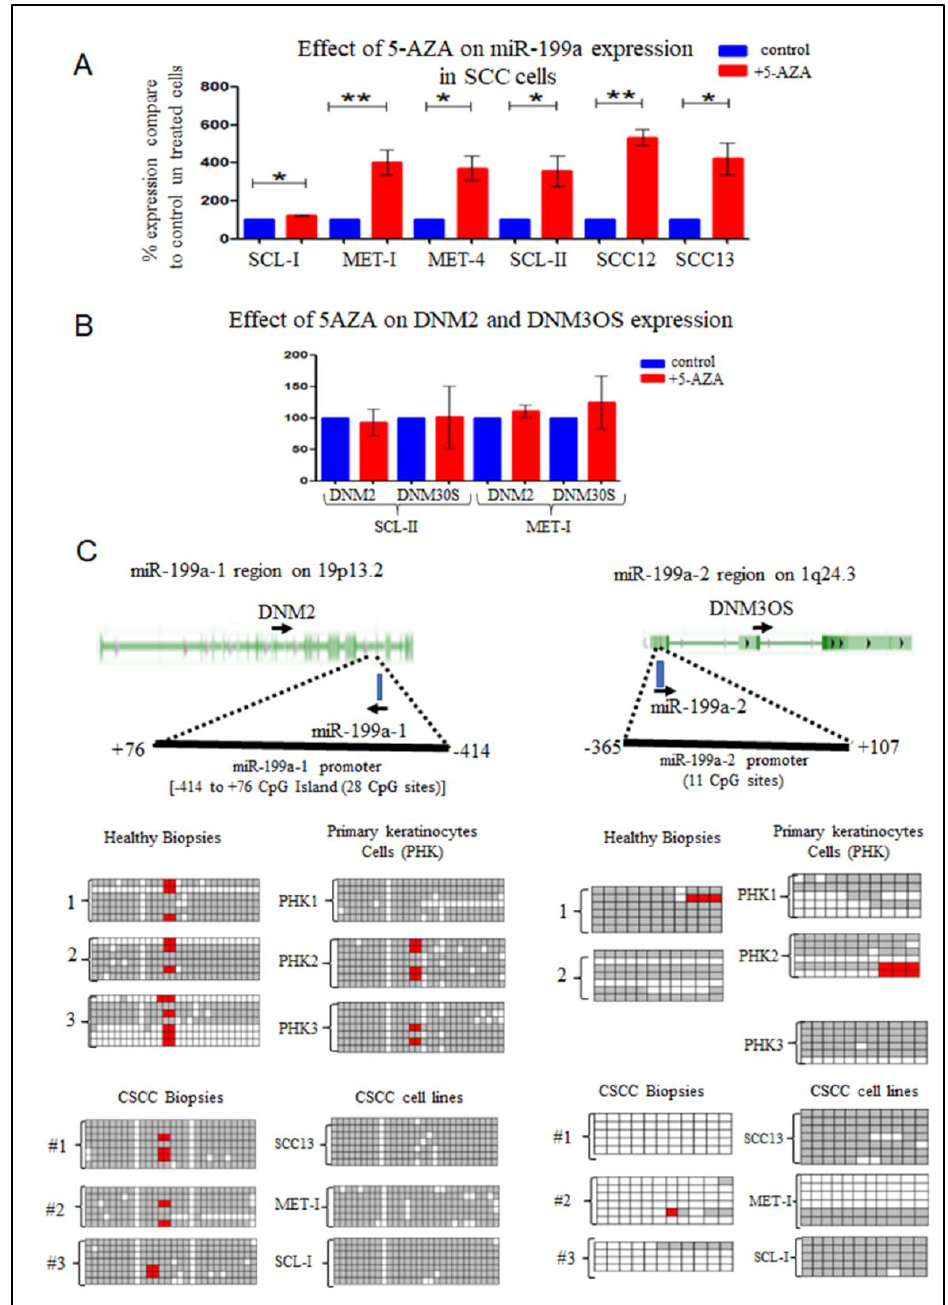
Figure 2. DNA methylation affects miR-199a expression. ( A ) Six CSCC lines were treated with 5-AZA for 5 days. Next, RNA was extracted from both treated and control untreated cells and was subjected to qRT-PCR as written in Figure 1. The mean − /+ SD was calculated from at least 6 independent experiments. Statistics were performed using a t -test (* p < 0.05) (** p < 0.01) ( B ) The effect of treatment with 5-AZA for 5 days on the expression of DNM2 and DNM3OS. ( C ) In the upper panel drawn a scheme of the genomic region of miR-199a-1 and miR-199a-2 genes and the location of the CpG island that was analyzed. Genomic DNA was extracted from three different PHK lines and three different CSCC cell lines or 3 healthy skin biopsies and 3 CSCC biopsies. The genomic DNA was subjected to bisulfite treatment. The treated DNA was subjected to PCR amplification and cloned into PUC19 (see Materials & Methods). From each sample at least 5 sequencings were performed (gray square represents methylated C residues, the white square represents un-methylated C residue, red represents unclear seq of the residue or missing C